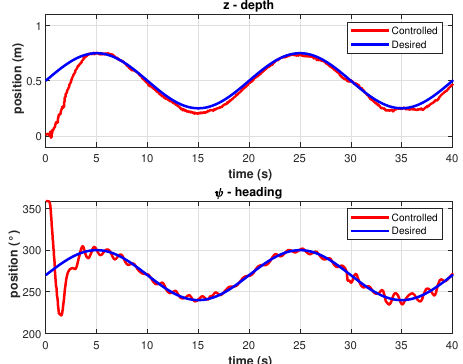
Figure 8. Controlled trajectories with the PID